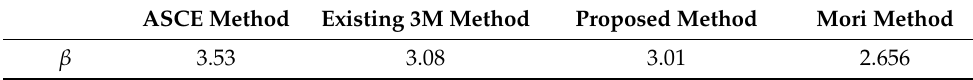
Table 5. Reliability of MC simulation with different